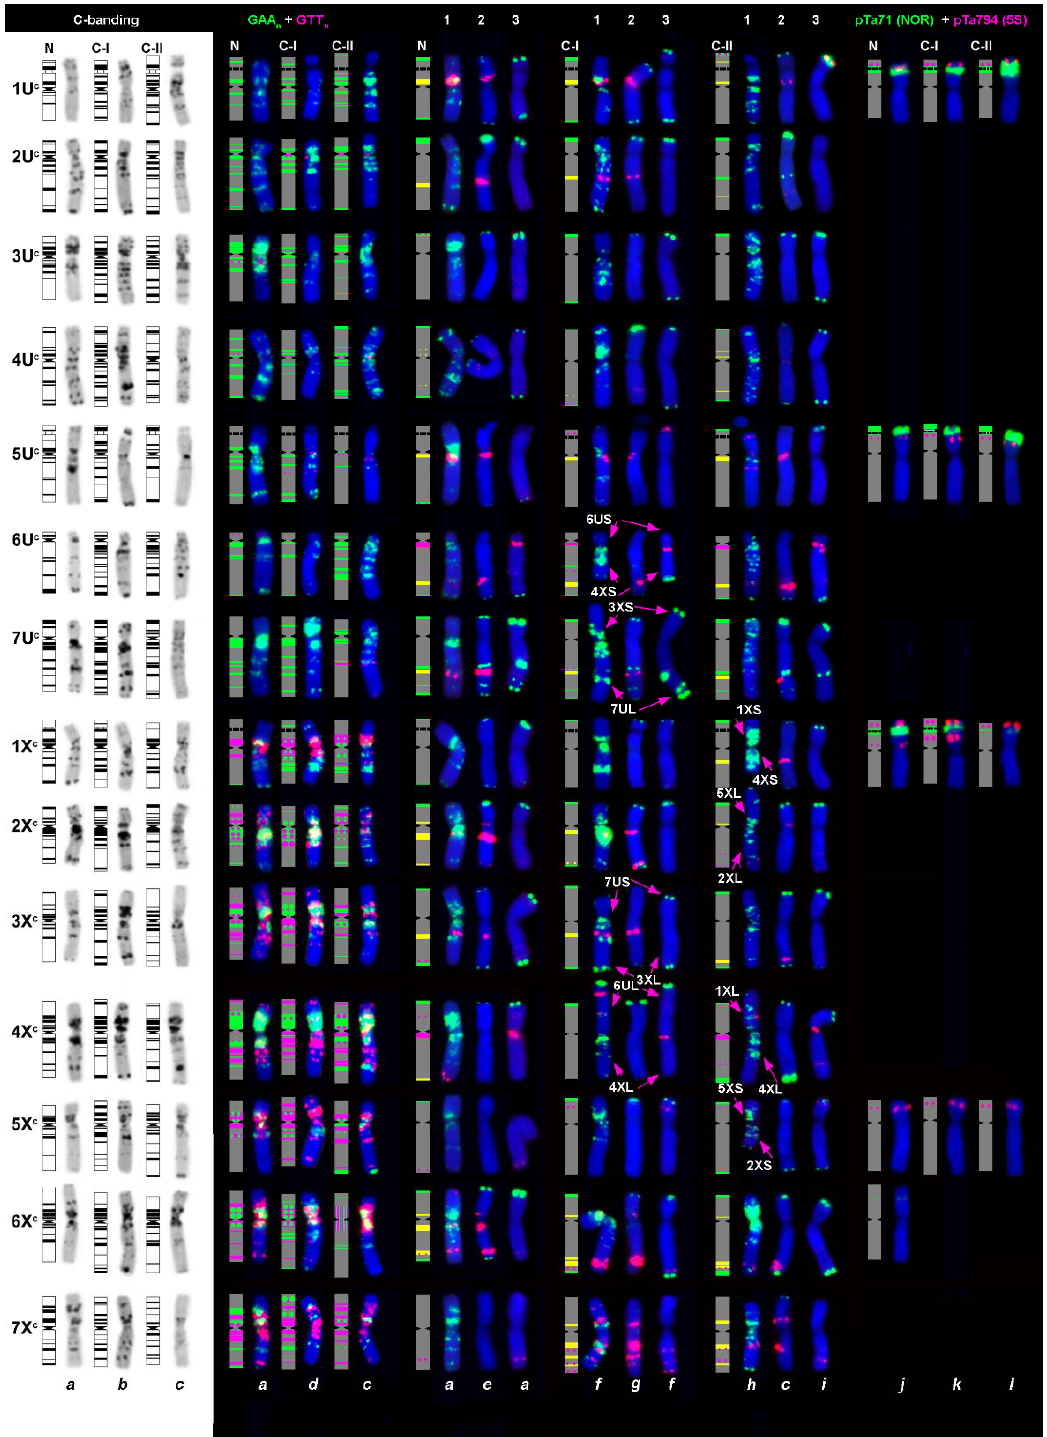
Figure 8. Comparison of the C-banding patterns with the distribution of different types of repeats on chromosomes of Ae. neglecta (N) and C-I and C-II groups of Ae. columnaris. The color of (GAA) n , (GTT) n , pTa71, and pTa794 probes on the respective idiograms corresponds to their color on chromosomal images. Probe combinations: 1—(GAA) n (green) + pTa − 713 (red); 2—pSc119.2 (green) + pTa − 713 (red); 3—pSc119.2 (green) + pAs1 (red). Positions of pSc119.2 sites on idiograms are shown in green, pAs1—in pink, and pTa713—in yellow. Accessions codes: ( a )—PI 564182, ( e )—K − 4233; ( j )—PI 170209 (Ae. neglecta); ( b )—H − 1 (sample provided by Dr. H. Ozkan); ( d )—i − 570045; ( f )—PI 554181; ( g )—K − 2680; ( k )—AE 1607 (Ae. columnaris, C-I); ( c )—PI 564180; ( h )—TA2084; ( i )—PI 564181; ( l )—PI 542181 (Ae. columnaris, C-II). Arm combinations on rearranged chromosomes are labeled.